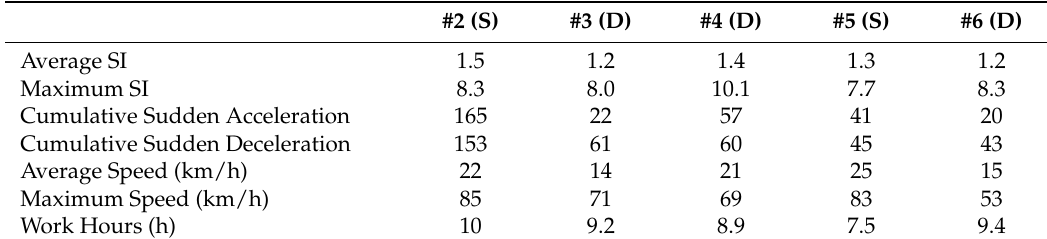
Table 11. Comparison of SI values and components of the dynamic and workload factors for five postal motorcyclists working in Cheongju on 5 November 2015. In the first column of the table, (S) signifies a postman delivering to a suburb of Cheongju and (D) signifies a postman delivering in downtown Cheongju.